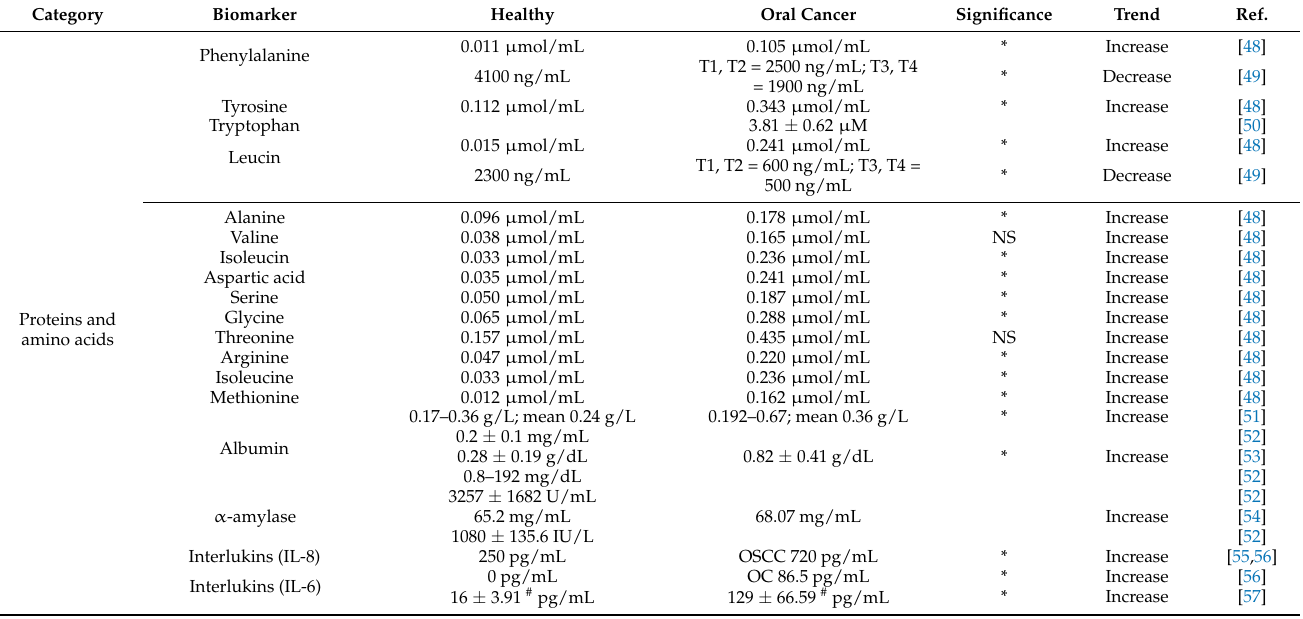
Table 3. Important salivary biomarkers for oral